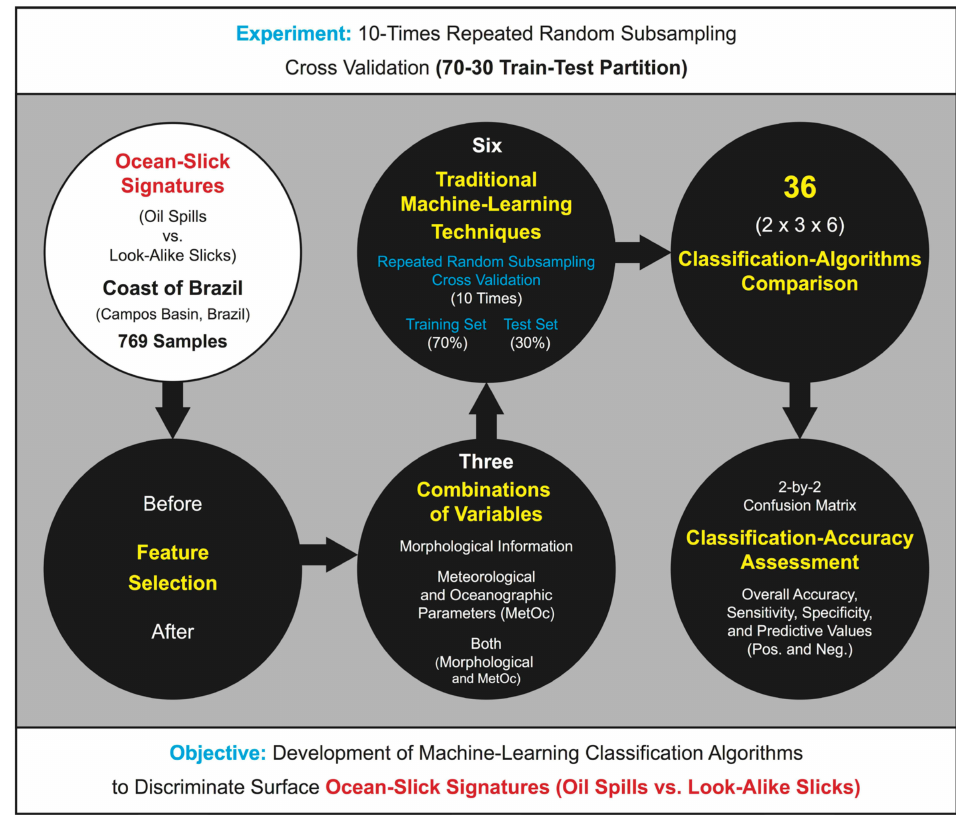
Figure 1. Flow diagram summarizing the architecture of the proposed experiment, which is interra- cially related to our objective. See Section 2.1: Research